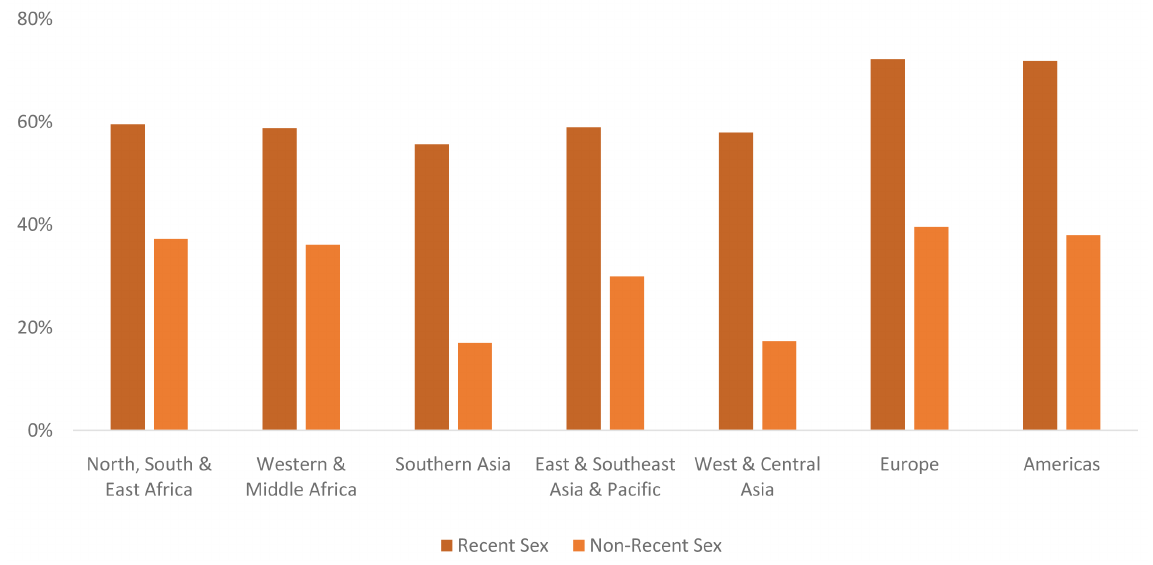
Figure 10. CPR by region for never-married market segments in 2040. This graph shows the contraceptive prevalence rate (CPR) among two of the never-married segments (recent sex and non-recent sex) by region. There is wide regional variation in CPR levels and in the differential between those who had recent sex and non-recent sex.